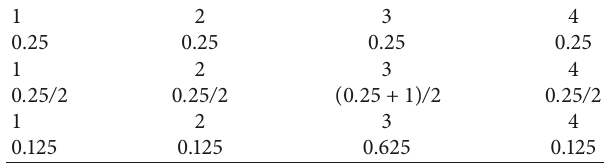
Table 1: Examples of meeting frequency.